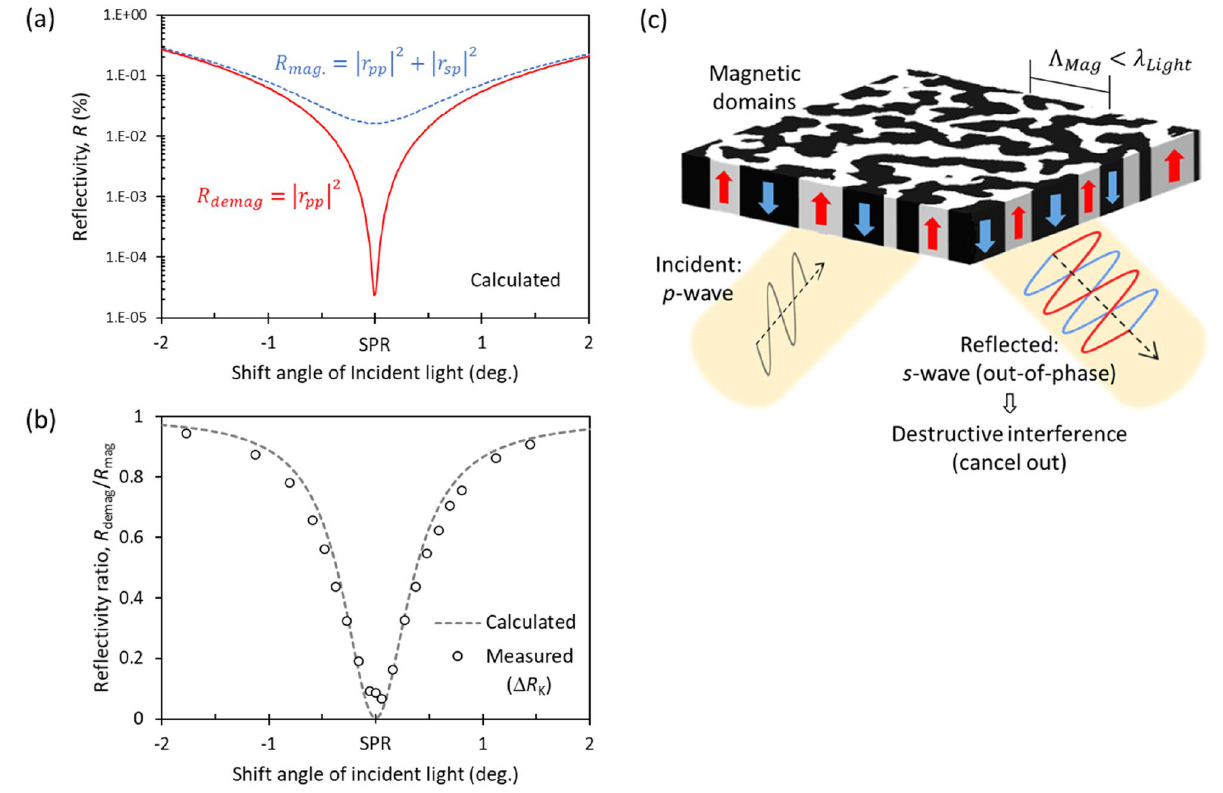
Figure 6. ( a ) Calculated reflective spectra for the MO–SPR element under magnetized (blue dashed line) and demagnetized (red solid line) states. ( b ) Calculated (gray dashed line) and measured (open circles) reflective ratios under both states. The reflective responses are plotted as a function of the shift angle from the SPR condition. ( c ) Schematic of MO destructive interference caused by the orthogonal transformation of polarization by subwavelength magnetic domain